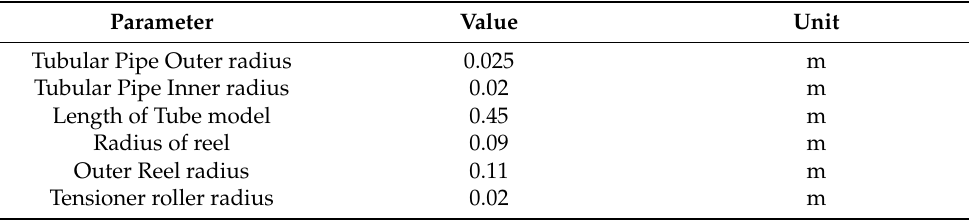
Table 1. Parameters for tubular pipe